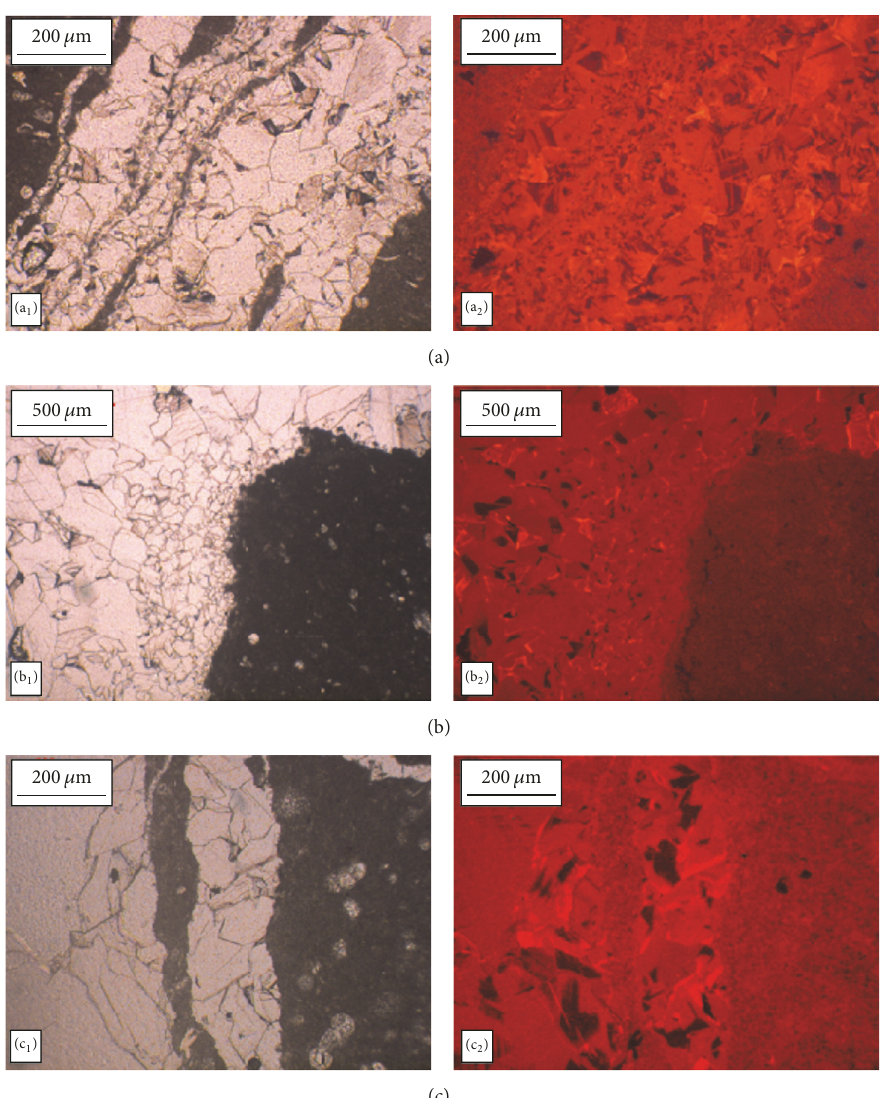
Figure 4: Microscopic observations under plane-polarized transmitted light (1) and cathodoluminescence (2) . (a) Group I veins with visible sector zonations. (b) Hydraulic breccia cemented by drusy calcite cement. (c) Group I veins with sector zonations visible under